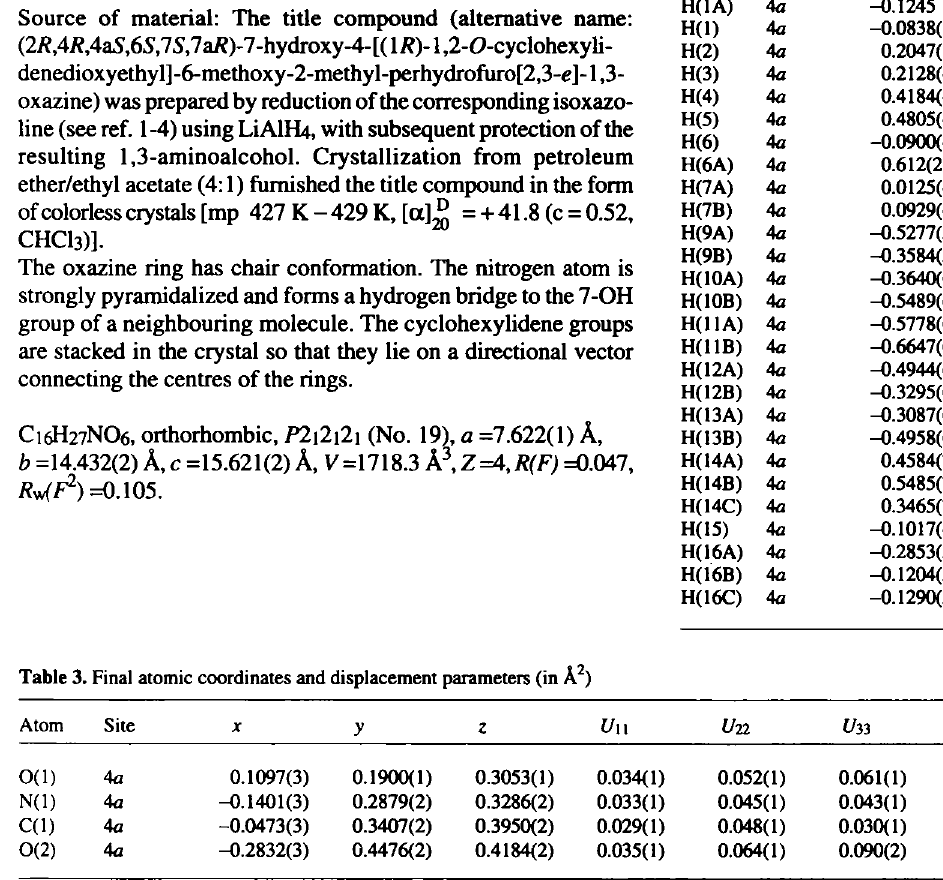
Table 2. Final atomic coordinates and displacement parameters (in Â^)